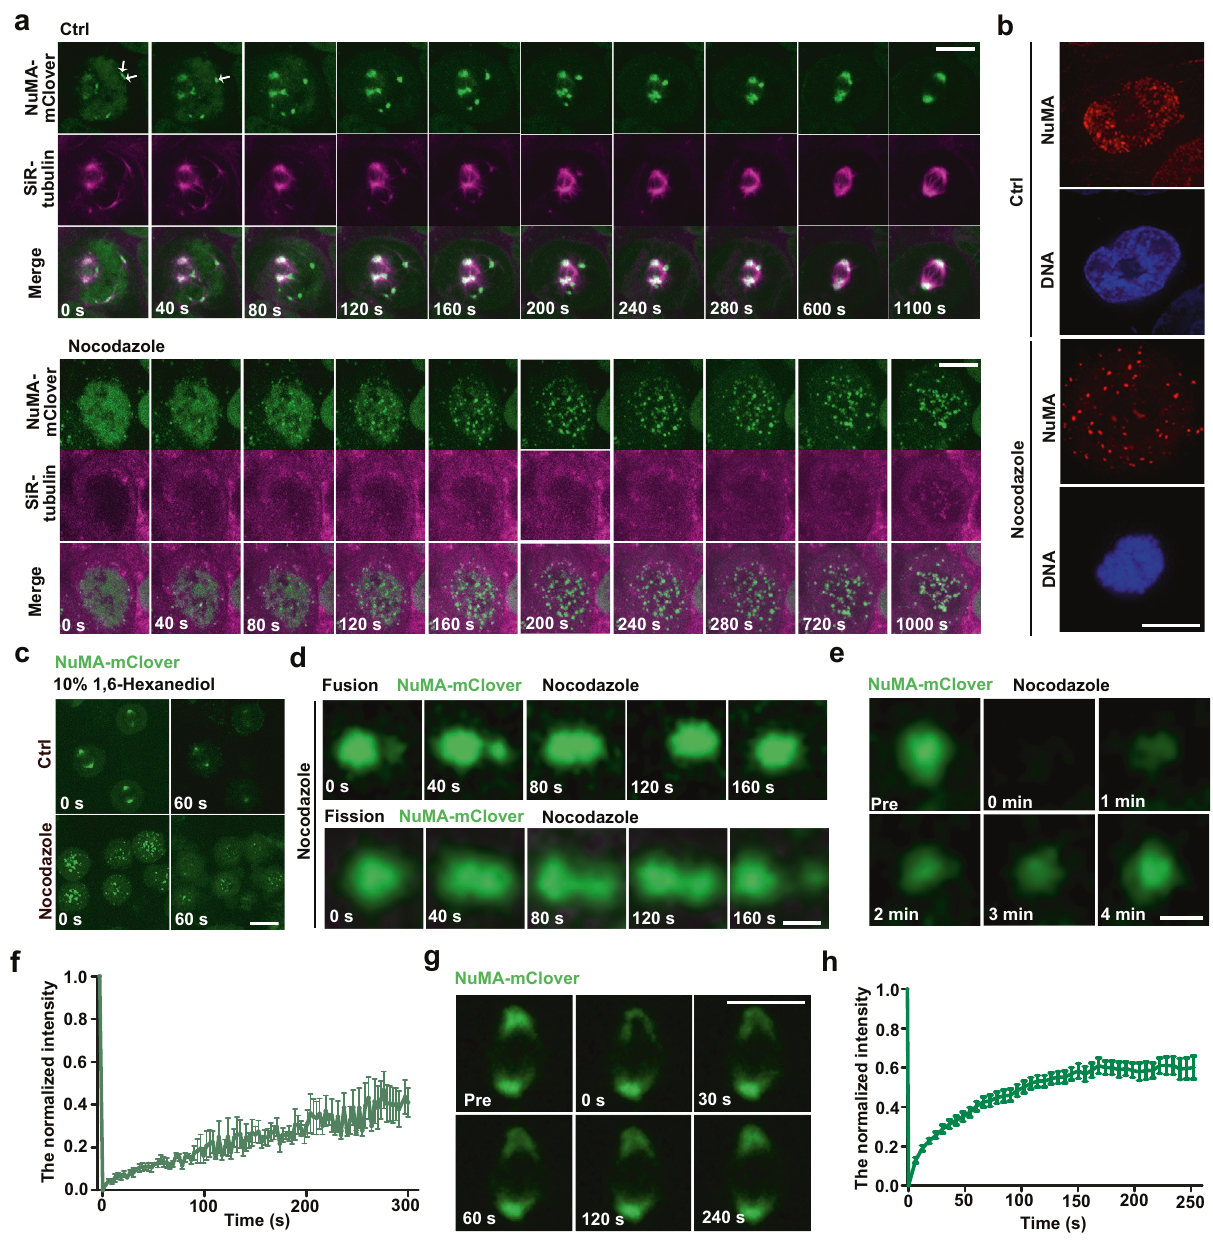
Fig. 2 NuMA phase-separates during G2/M transition. a Time-lapse images showing endogenous NuMA tagged with mClover forms droplets spontaneously along with NEBD in both control and nocodazole-treated NuMA-mACF cells. Images were collected every 40 s. Microtubules were probed by SiR-tubulin. The arrows indicated the NuMA droplet fusion. b Immuno fl uorescence images showing the endogenous NuMA condensates in control or nocodazole-treated mitotic HeLa cells, followed by staining with anti- α -NuMA antibody (red) and DAPI (blue) for DNA. c Time-lapse images showing the dynamics of NuMA droplets in NuMA-mACF cells. Note that NuMA droplets were located to spindle poles in cells without nocodazole treatment and to the cytoplasm when the cells were treated with nocodazole and that the droplets disappeared in both nocodazole- and non-nocodazole-treated cells within 60 s in the presence of 10% hexanediol. d Time-lapse imaging showing fusion and fi ssion of endogenous NuMA-mClover droplets in nocodazole-treated mitotic NuMA-mACF cells. Scale bar, 1 μ m. e , f Time-lapse images ( e ) and quanti fi cation ( f ) of fl uorescence recovery after photobleaching (FRAP) of endogenous NuMA-mClover droplets after photobleaching in nocodazole-treated NuMA-mACF cells (mean ± SEM, n = 6 droplets). Scale bar, 1 μ m. g , h Time-lapse images ( g ) and quanti fi cation ( h ) of FRAP of endogenous NuMA-mClover on the spindle pole after photobleaching in NuMA-mACF cells (mean ± SEM, n = 20 cells). Scale bars, 10 μ m unless speci fi ed